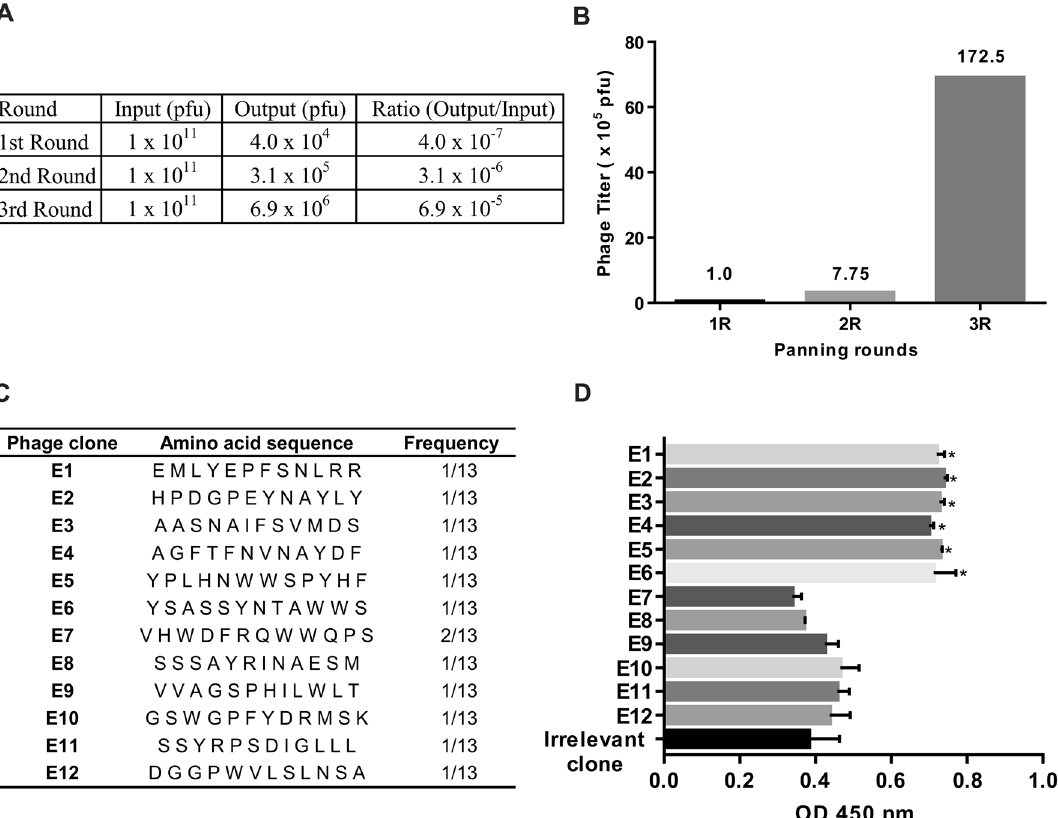
Figure 2. Biopanning, enrichment of phage library and perfomance of the phage clones selected by phage display. ( A ) The phage titer after each biopanning round, ( B ) Three rounds of biopanning against ECP were performed, and the phage titer (pfu) after each round was measured. Numbers on bars are the enrichment fold of the phage titer over the first round, ( C ) amino acid sequences and frequency of the selected peptides, ( D ) reactivity obtained though the interaction of the sequenced phage clones, Irrelevant phage clone and